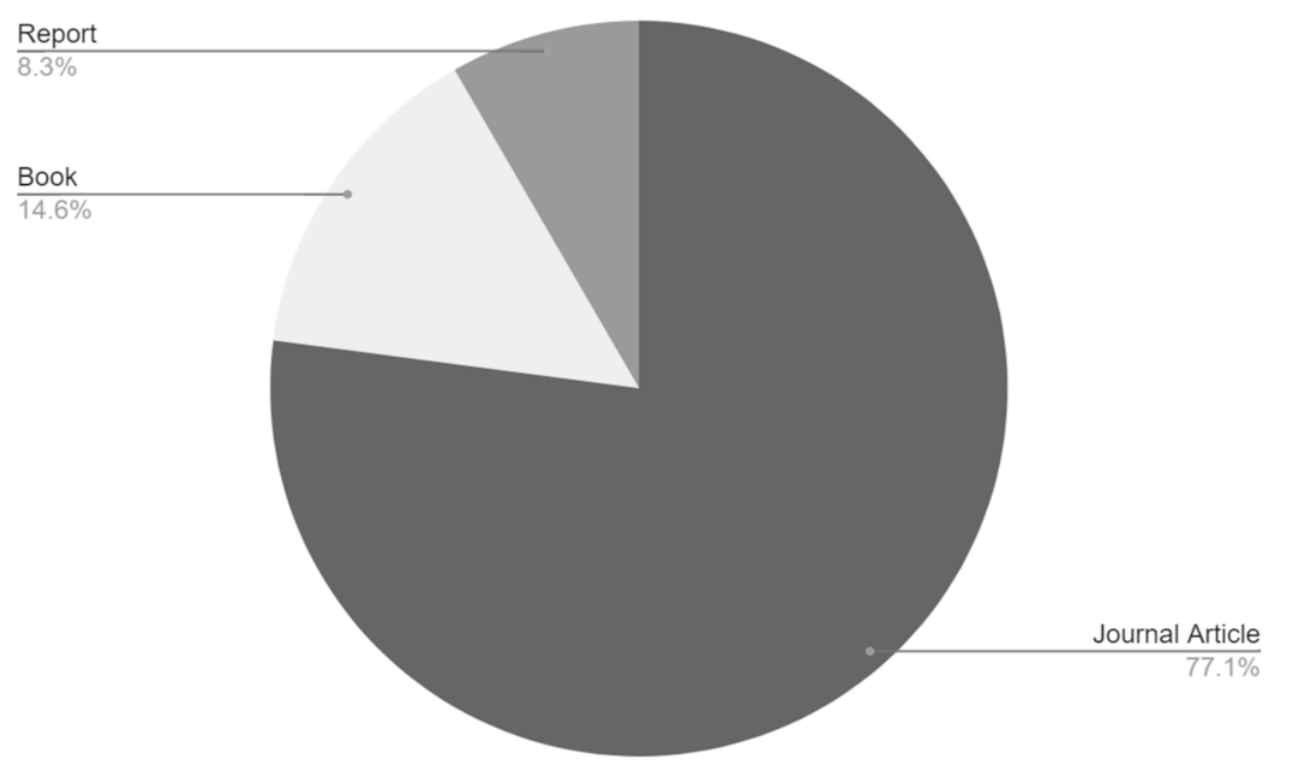
Figure 3. Interactive visualization of the 48 studies comprising the evidence base https://oxsrev.github.io/evidencemaps/ woodfuel/ (accessed on 17 August 2021).